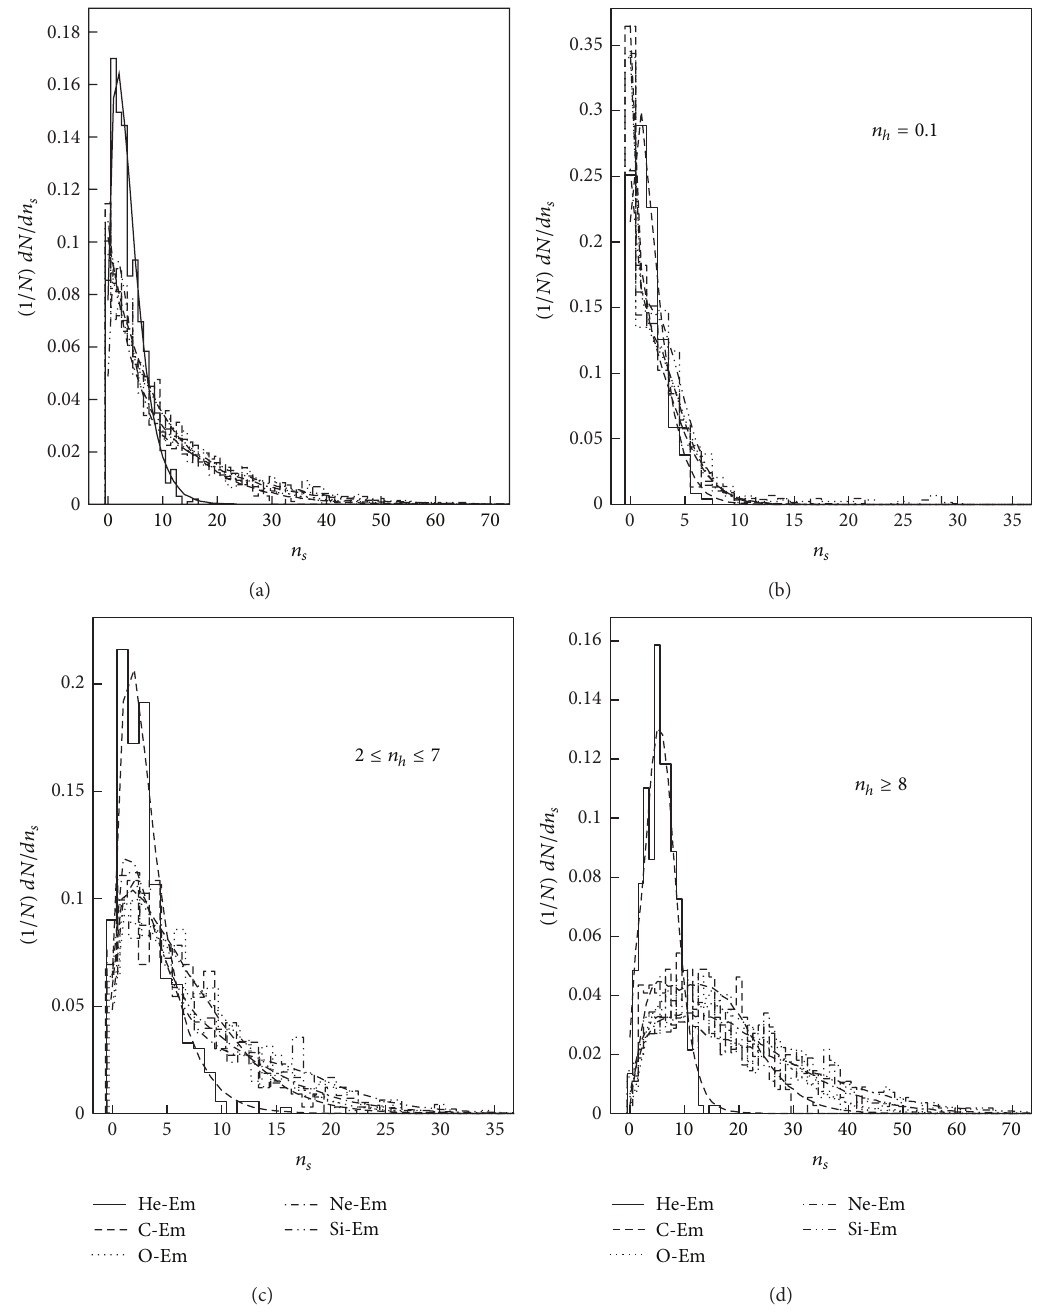
Figure 1: The normalized multiplicity distributions for shower particles produced in the interactions of projectiles with (a) Em, (b) H, (c) CNO, and (d) AgBr, respectively. The histograms represent the experimental data, while the curves are the corresponding ones calculated according to the multisource thermal